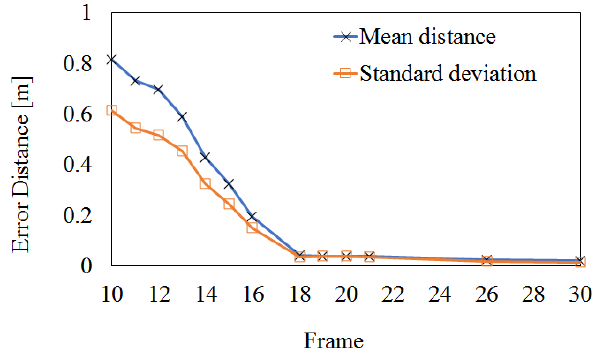
Figure 14. Numerical result of 3D registration error of the Charuco board.